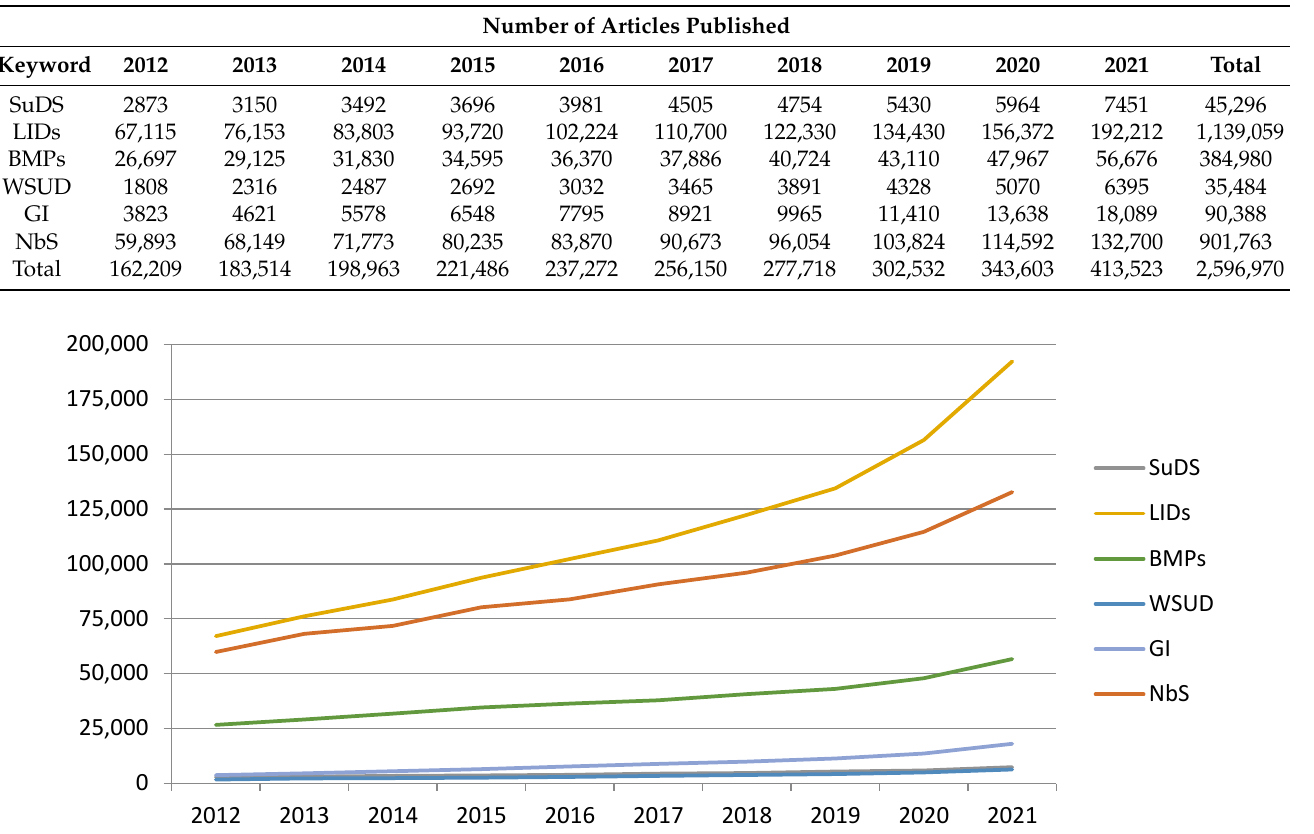
Figure 1. Evolution of scientific articles published on the topic of “soil sealing” according to the keywords